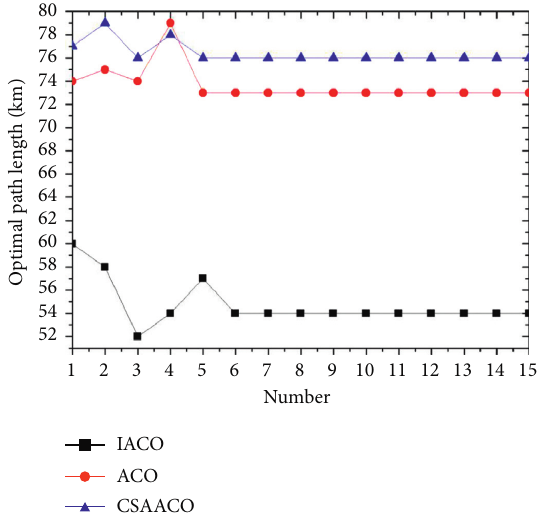
Figure 3: The optimal logistics distribution path length comparison.